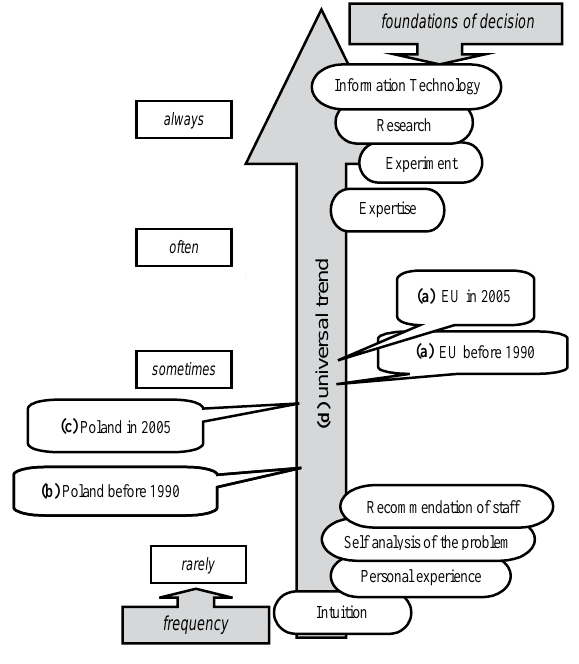
Fig. 2. Trends in changes in approach towards decision techniques and